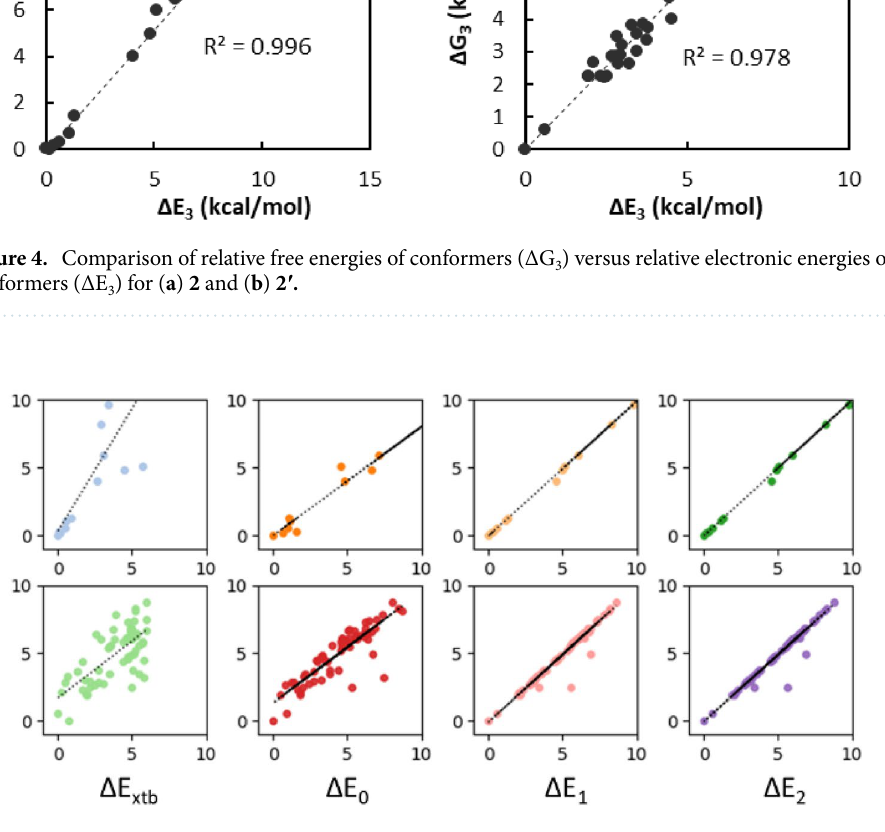
Figure 5. Comparison of thermochemical recipes against ΔE 3 for conformer ensembles of 2 and 2 ′ (all units are kcal/mol).